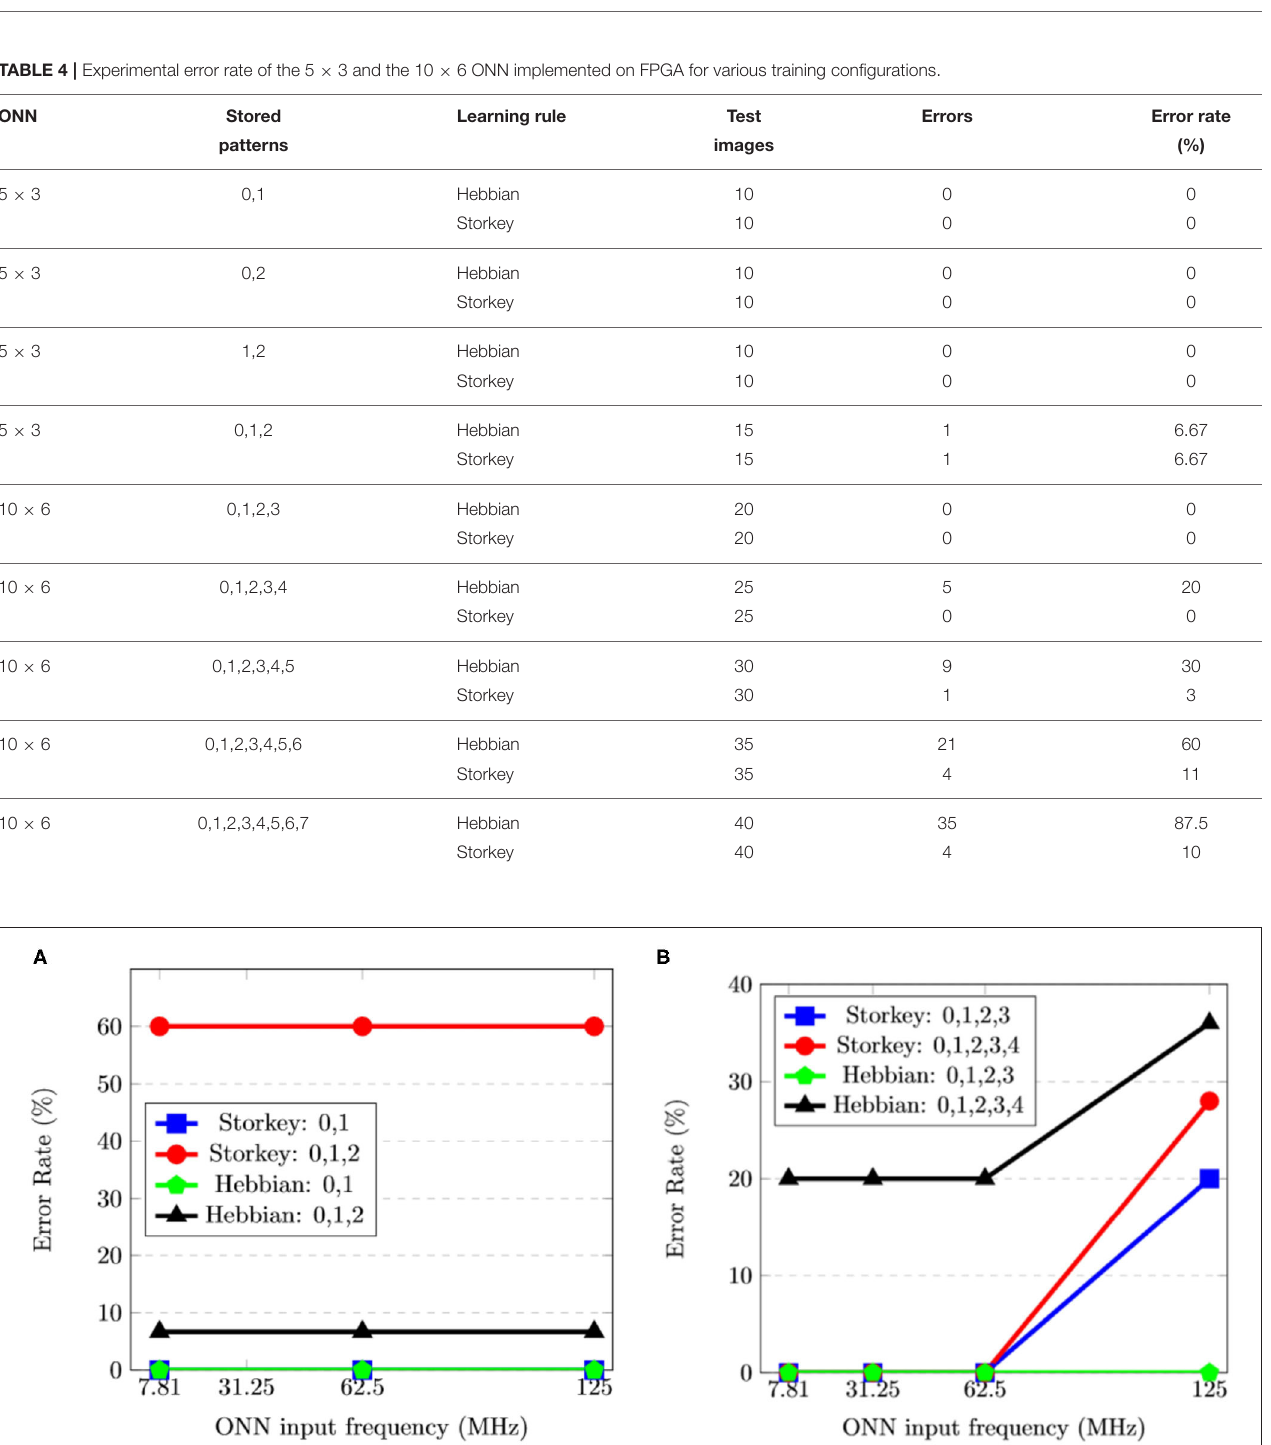
both 5 × 3 and 10 × 6 ONNs. So, ONN size does not impact the computation time, which is an important feature of ONN to further explore design methods to upscale its